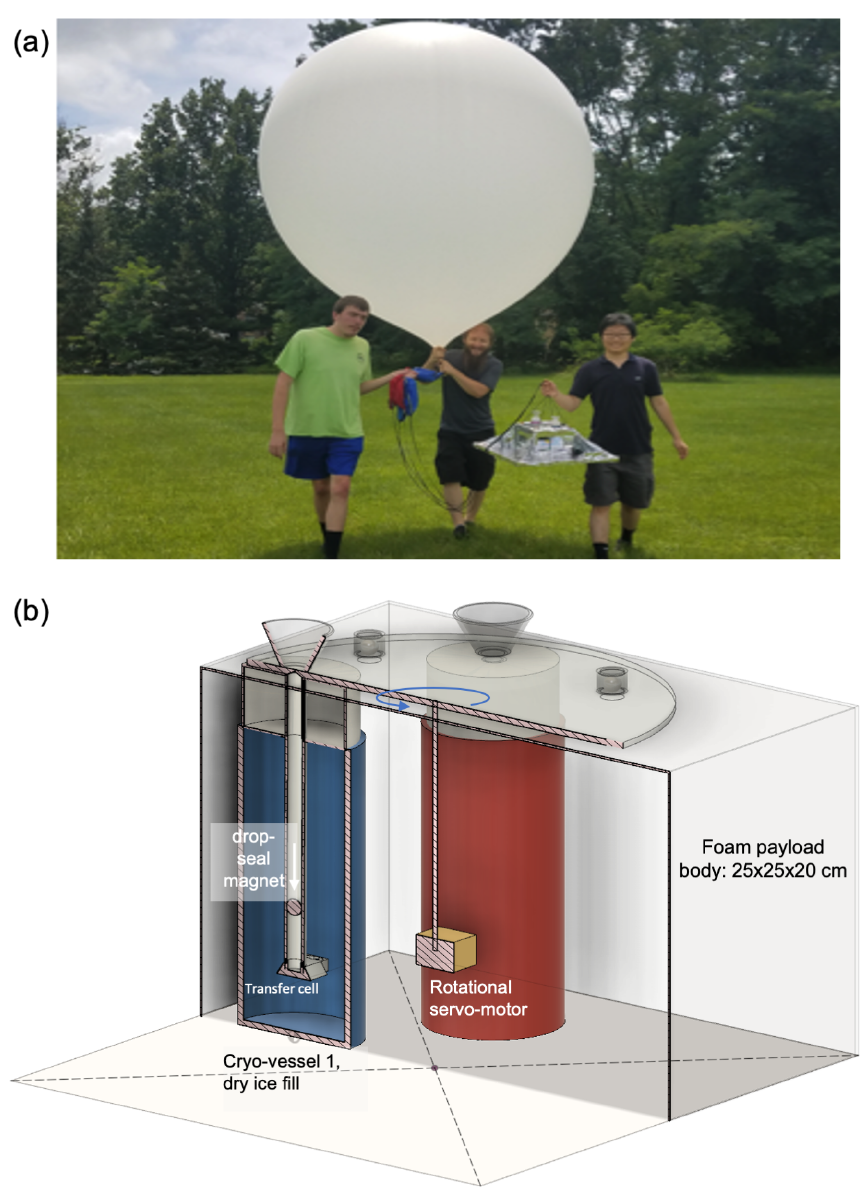
Figure 1. ICE-Ball balloon and payload photo at pre-launch (a) with co-authors Lynn, Tusay, and Zhao (left to right). Diagram of servo-driven sealing of cryo-capture vessels and positioning within the ICE-Ball payload (b)